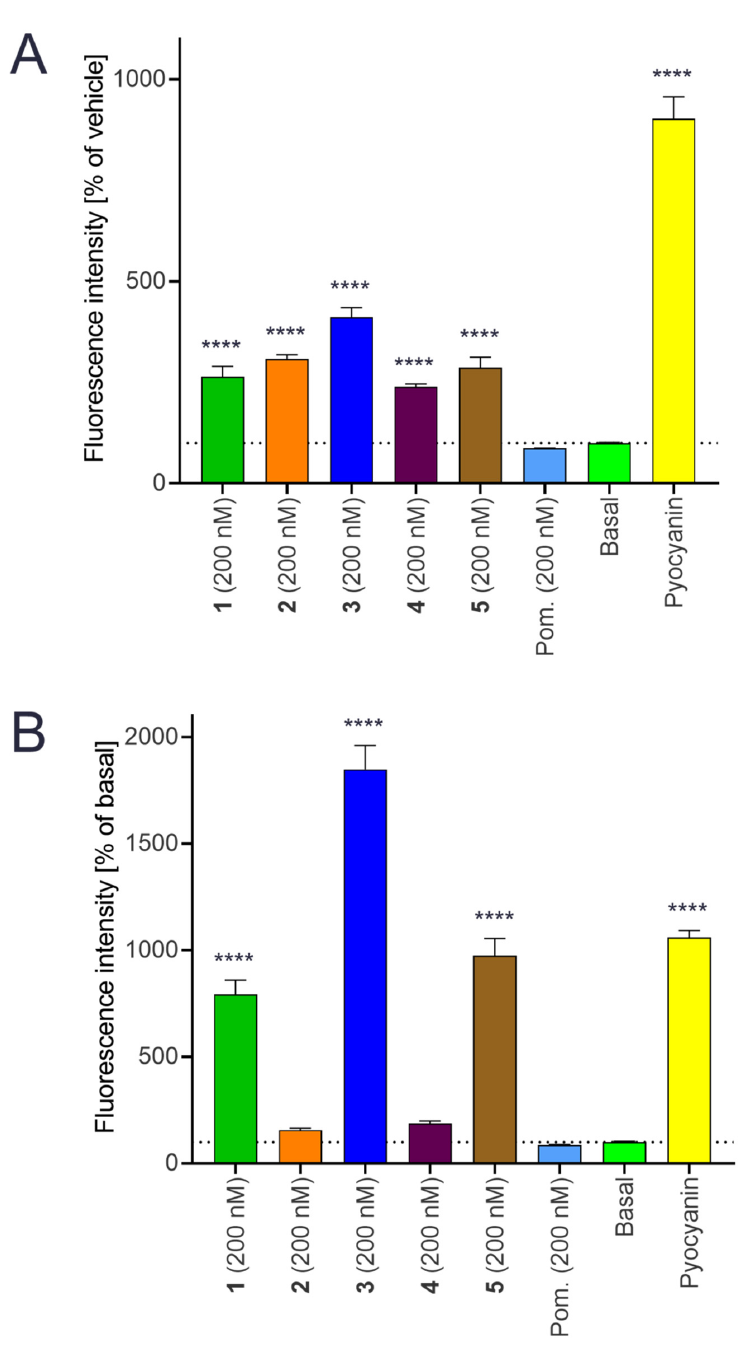
Figure 10. Effect of the complexes 1 – 5 on the ROS production in THP-1 cell line. The cells were treated with the complexes 1–5 (200 nM), pomiferin (Pom.; 200 nM), Pyocyanin (100 µ M) or only with vehicle (basal) for 1.5 h ( A ) or 23.5 h ( B ). Then DCF-DA probe was loaded to cells and after another 30 min, the fluorescence was measured. Graph represents mean ± SEM. Dotted line show the value of basal group. **** indicates statistical significance ( p ≤ 0.0001) to basal group.